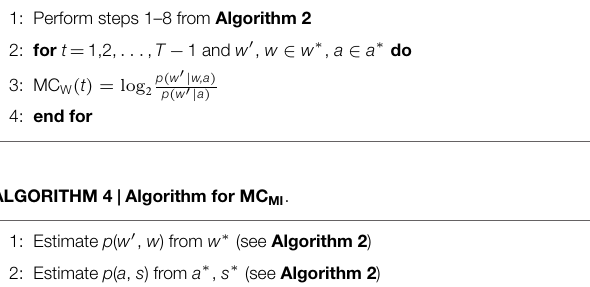
ALGORITHM 3 | Algorithm for state-dependent MC W ( t ) .